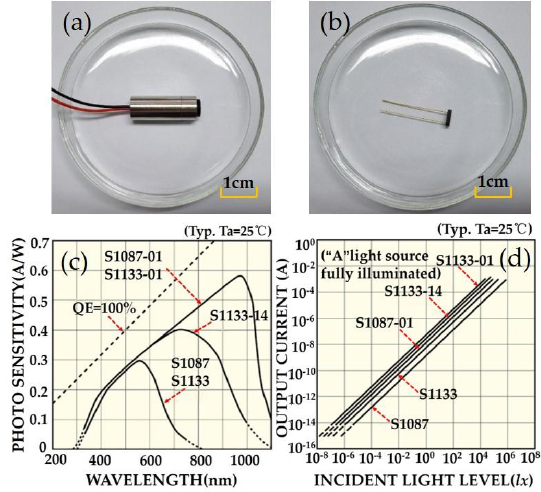
Figure 2. The photograph of ( a ) laser light source and ( b ) photodetector. ( c ) The spectral response curves for different photodetectors, and ( d ) corresponding current response to the light intensity.